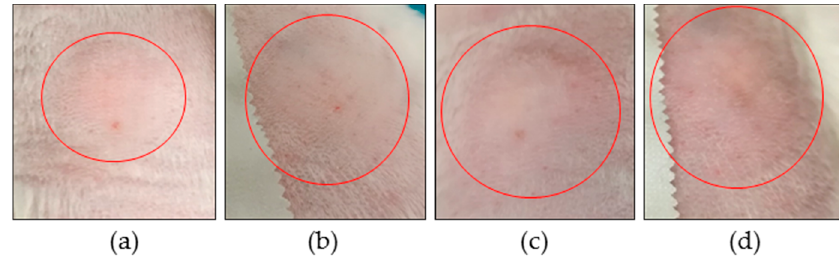
Figure 3. Photographs of histamine wheal suppression test at 30 min. ( a ) HB–menthone; ( b ) HB– nonane; ( c ) HB (in Transcutol ® ); ( d ) control without HB. Red circles indicate wheal formed.